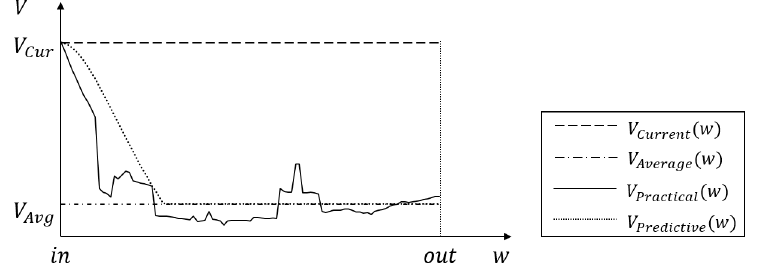
Figure 1. The speed of the requester vehicle according to its locations ( w ) within the communication range (between the arrival point in and the departure point out ) of the next RSU when different speeds are used for calculating the amount of the precached